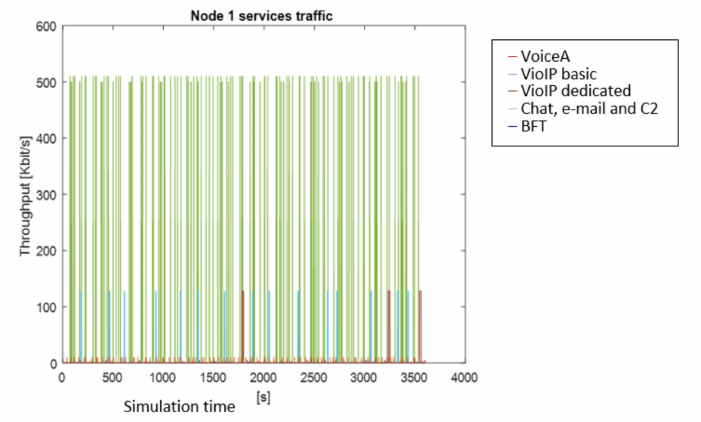
Figure 9. Traffic generated by particular services of Node 1.